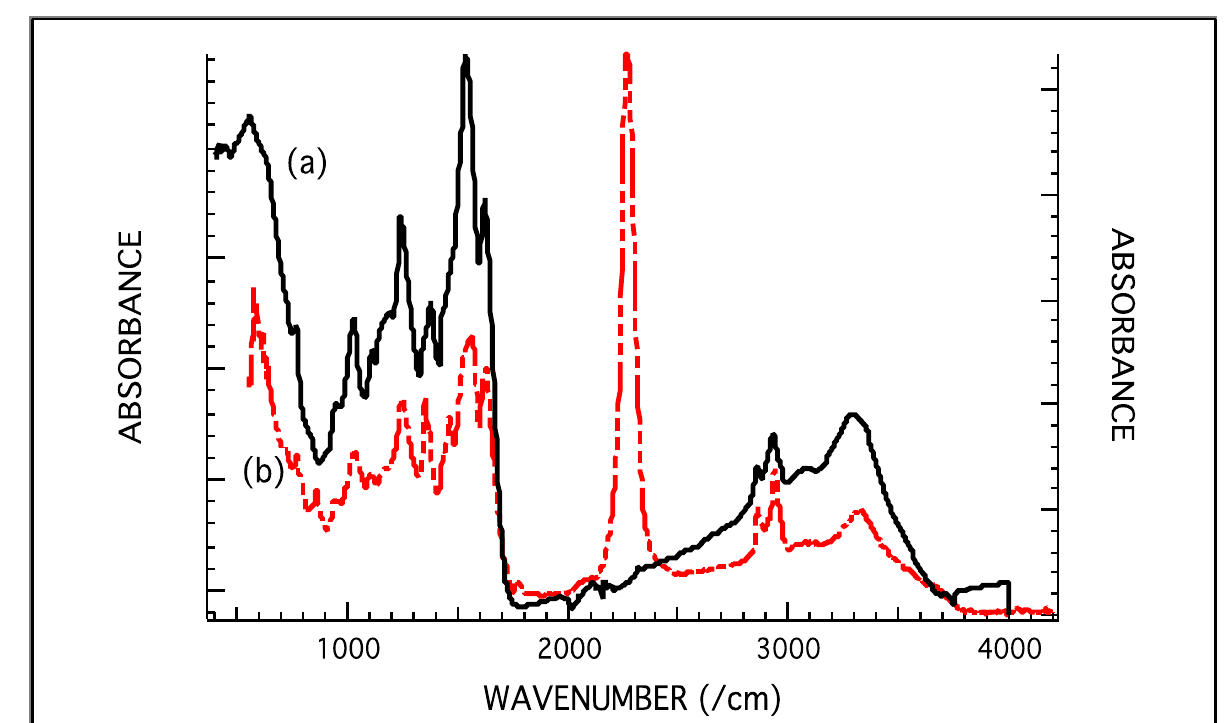
Figure 12. FTIR of microcapsules with a water:oil ratio of 5.5:1 compared with FTIR of the same microcapsules after aging for 4 months. (a) Microcapsules aged for 4 months; (b) Original microcapsules.